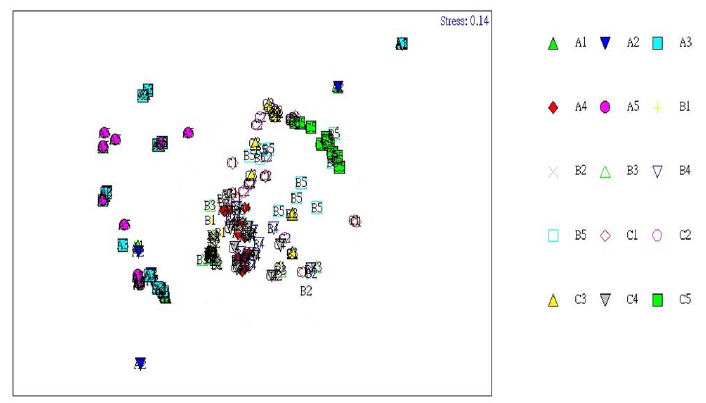
Figure 4. Non-metric MDS ordination of abundance data for crab communities sampled monthly in the study area.